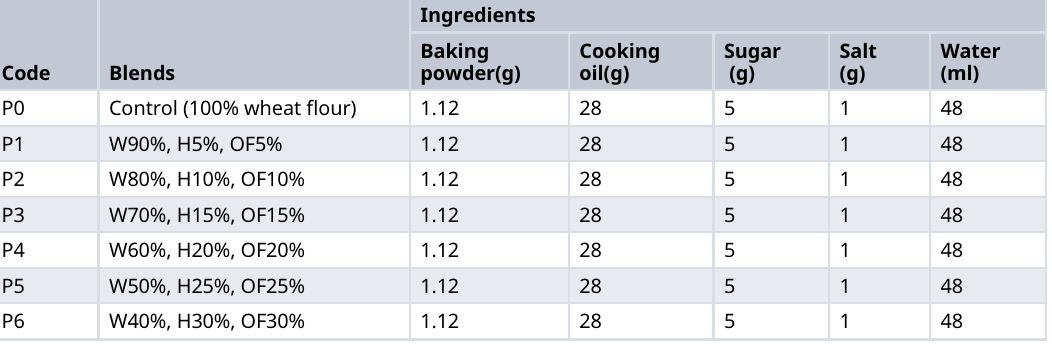
Table 1. Formulation of biscuits with orange-fleshed sweet potato and haricot bean